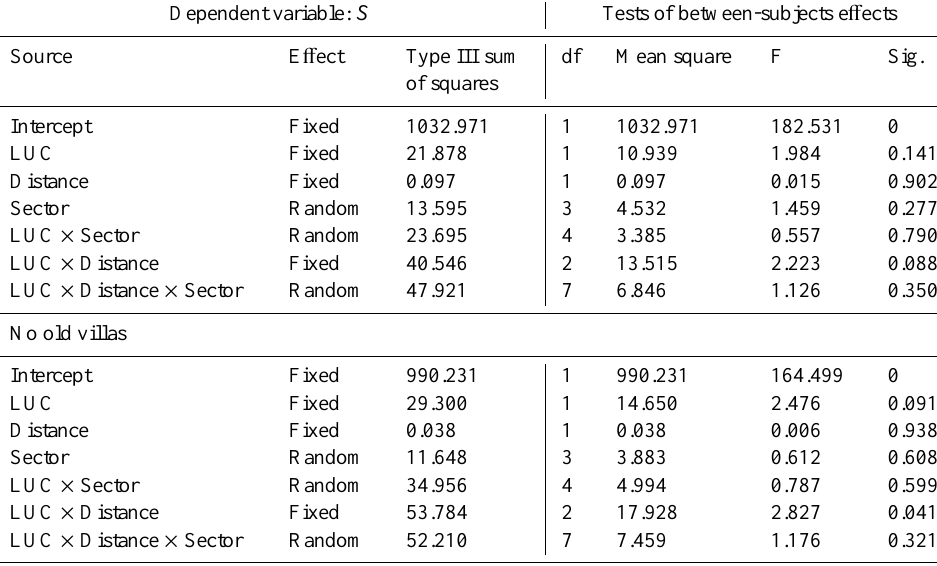
Table 5. GLM analyses of the e ff ects of two fixed factors (distance and land use category – LUC) and one random factor (sector) on the number of bird species ( S ) recorded at each point count station. The models were performed by using all the point count stations (above) and then repeated without considering the green areas belonging to the old villas (below).